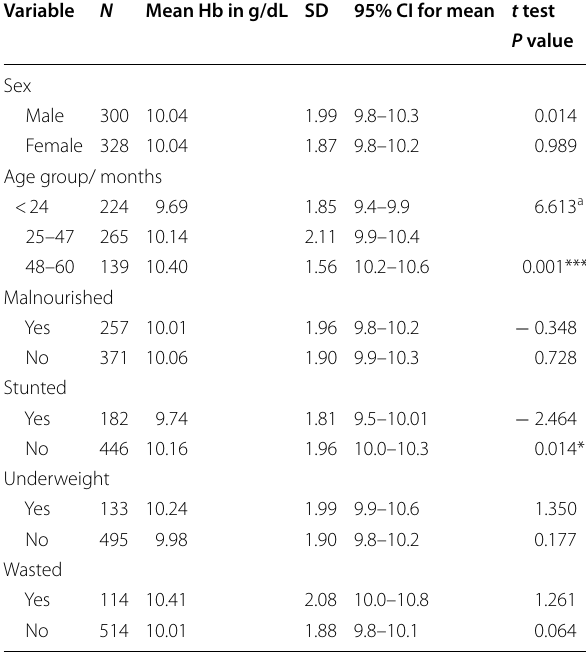
a Means compared using F test, *Statistically significant at P < 0.05, ***Statistically significant at P < 0.001